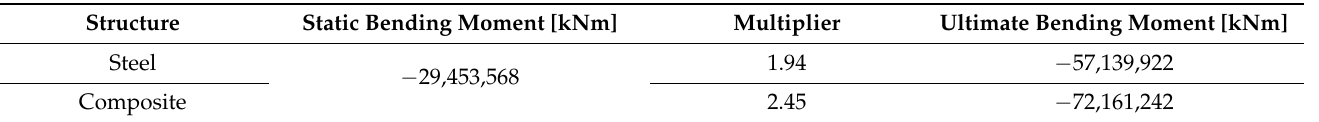
Table 12. Ultimate strength